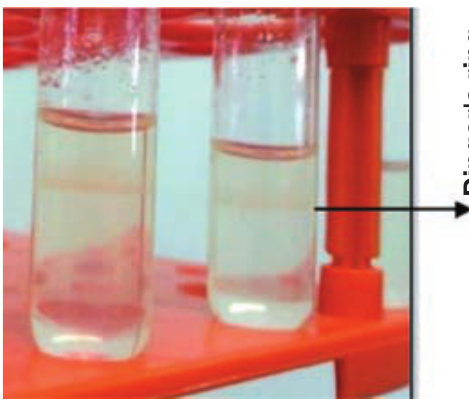
Fig. 1. Growth of leptospires in EMJH semi- solid medium